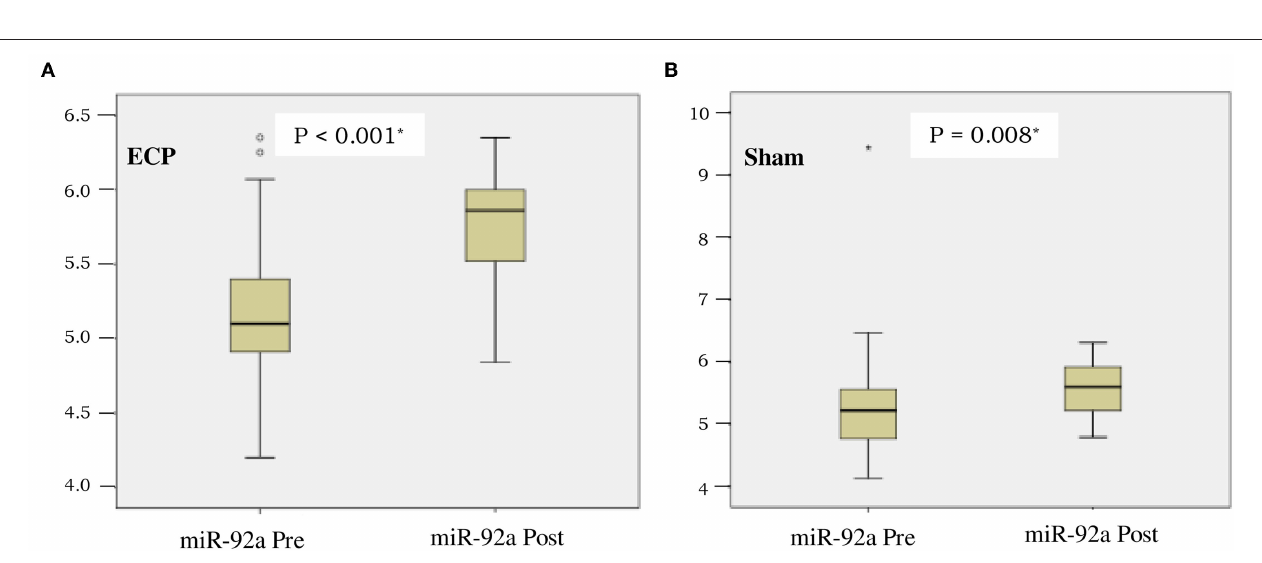
FIGURE 3 | Boxplot of microRNA-92a (miR-92A) expression before and after intervention in ECP group (A) and sham group (B) . *Analysis by Wilcoxon test.